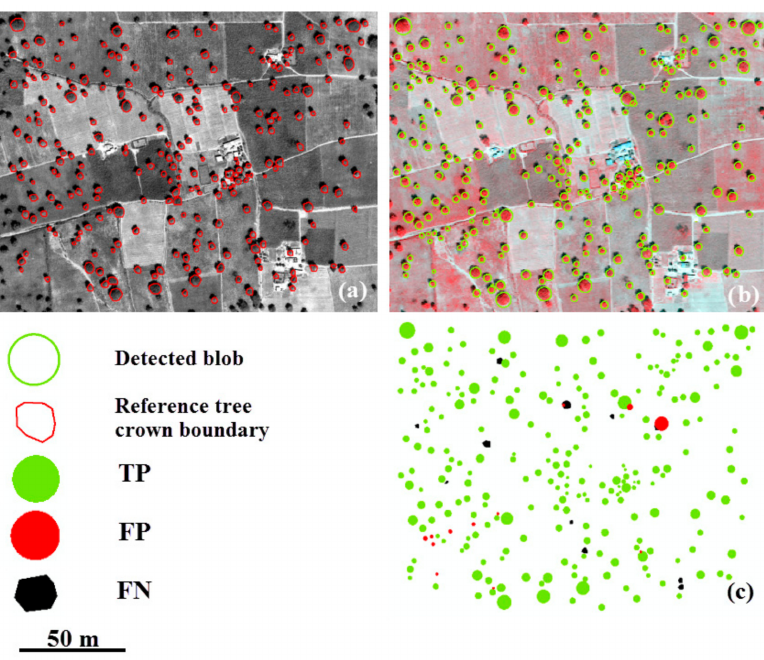
Figure 9. Results of tree detection in discrete Gaussian scale space with modified tree size measurements using f 3 ( s ). ( a ) Reference data from a panchromatic image; ( b ) Vitellaria trees with detected blobs; ( c ) The error